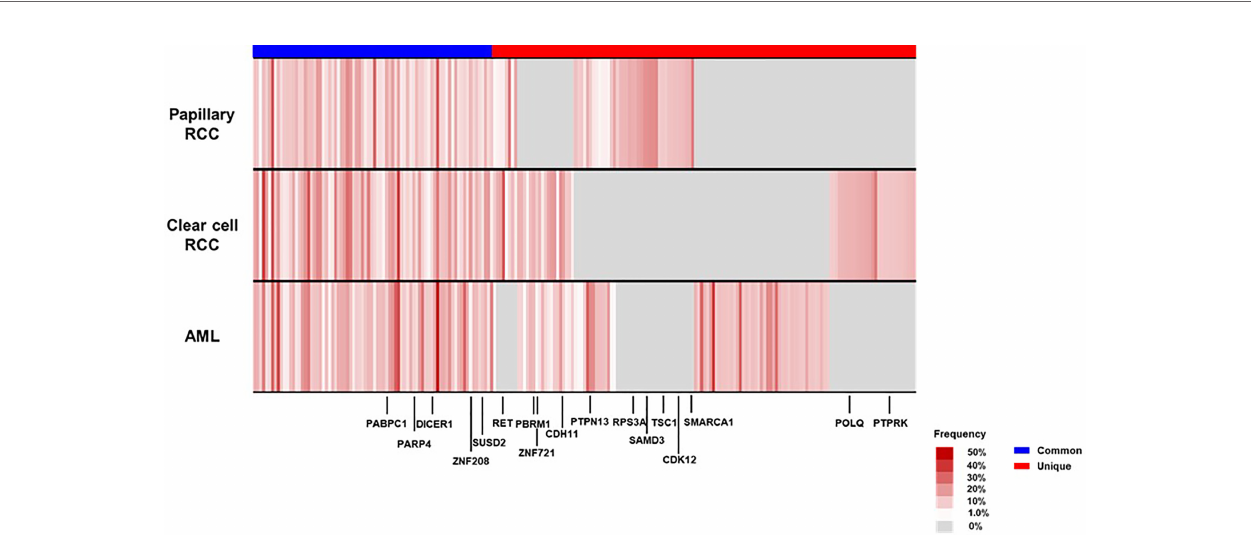
FIGURE 4 | Mutational landscape of the three renal tumors in the patient ’ s left kidney at fi rst recurrence. We visualized the somatic mutation pro fi les of each tumor — angiomyolipoma (AML), clear cell renal cell carcinoma (RCC), and papillary RCC — as heat maps (black-colored genes indicate driver gene mutations in many cancer types). CDH11 , Cadherin 11; CDK12 , Cyclin Dependent Kinase 12; DICER1 , Dicer 1; PABPC1 , Poly(A) Binding Protein Cytoplasmic 1; PARP4 , Poly(ADP-Ribose) Polymerase Family Member 4; PBRM1 , Polybromo 1; POLQ , DNA Polymerase Theta; PTPN13 , Protein Tyrosine Phosphatase Non-Receptor Type 13; PTPRK , Protein Tyrosine Phosphatase Receptor Type K; RET , Ret Proto-Oncogene; RPS3A , Ribosomal Protein S3A; SAMD 3, Sterile Alpha Motif Domain Containing 3; SMARCA1 , SWI/SNF Related, Matrix Associated, Actin Dependent Regulator Of Chromatin, Subfamily A, Member 1; SUSD2 , Sushi Domain Containing 2; TSC1 , TSC Complex Subunit 1; ZNF208 , Zinc Finger Protein 208; ZNF721 , Zinc Finger Protein